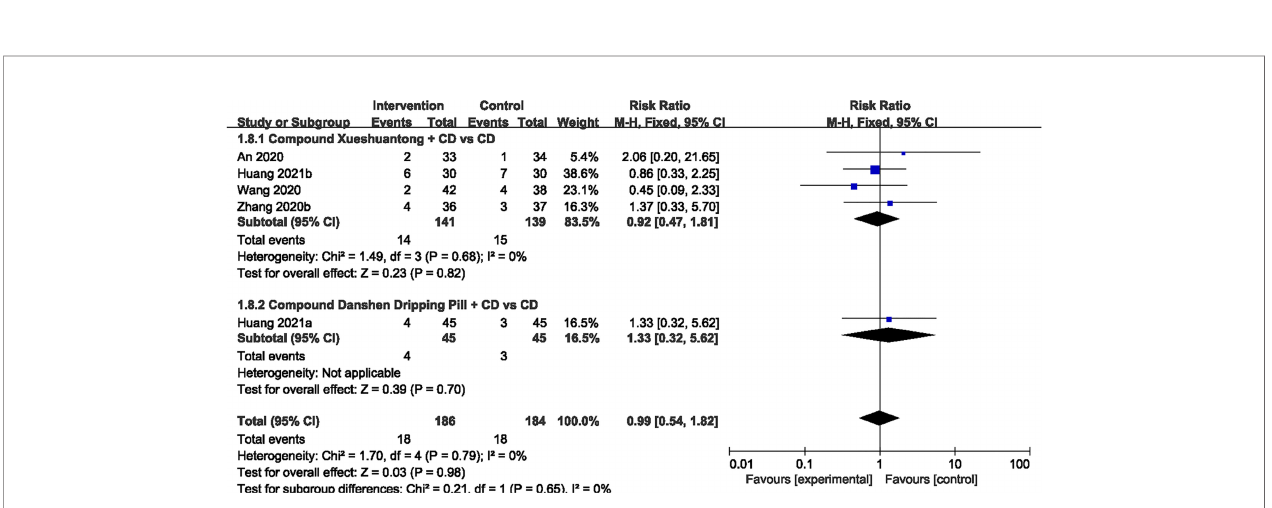
FIGURE 7 | Forest plots of comparison of blood sugar for CPMs plus CD versus CD alone. (A) FBG, (B)